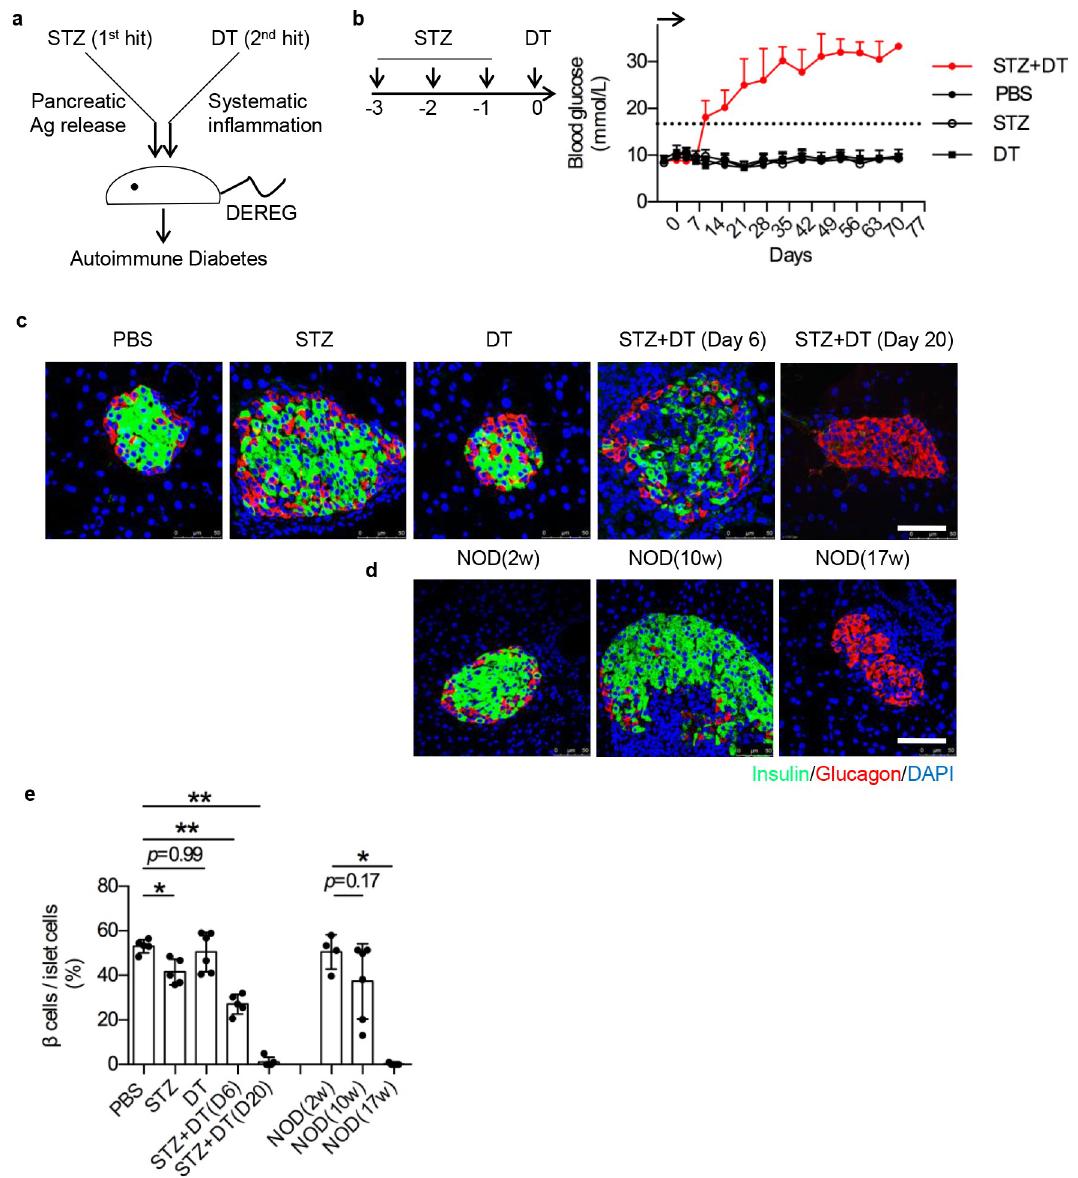
Fig 1. Establishment of double-hit model by STZ+DT. a . Rationale of double-hit model. Pancreas was first chemically damaged by multiple low-dose STZ to unleash auto-antigens, then was hit by systematic inflammation (Treg depletion by DT in DEREG mice). DEREG, DEpletion of REGulatory T cells. b . STZ and DT administrations. Left, scheme of model setup. Multiple low-dose STZ (50mg/kg) was i . p . injected to DEREG mice at day -3, -2 and -1. DT (0.25 μ g) was i . p . injected at day 0. Right, blood glucose fluctuation. PBS was given as control. Arrow represents model setup from day -3 to day 0. Dash line represents blood glucose at 16.7 mmol/L. n = 7. N = 5. c-d . Immunofluorescence staining of insulin (green), glucagon (red) and DAPI (blue) in pancreatic islets. PBS, STZ and DT group were analyzed at day 6. STZ+DT group were analyzed at day 6 and day 20 ( c ). NOD mice were analyzed at new- born (2-week of age, 2w), prediabetic phase (10-week of age, 10w) and diabetic phase (17-week of age, 17w) ( d ). Scale bars represent 50 μ m. e . Statistical analysis of β cell loss in terms of insulin + cell percentage per islet in c and d. n = 5. N = 3. � , p < 0.05; �� , p <